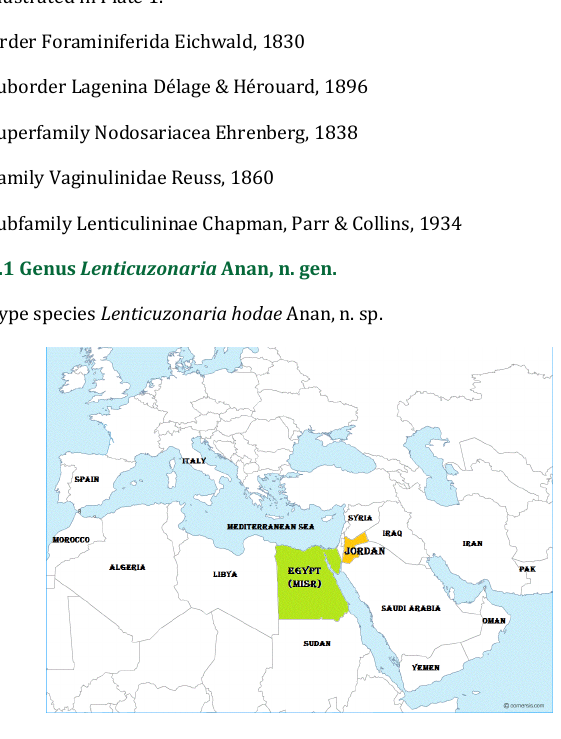
Figure 1: Geographic position of Egypt and Jordan, southeast of the Mediterranean Sea.